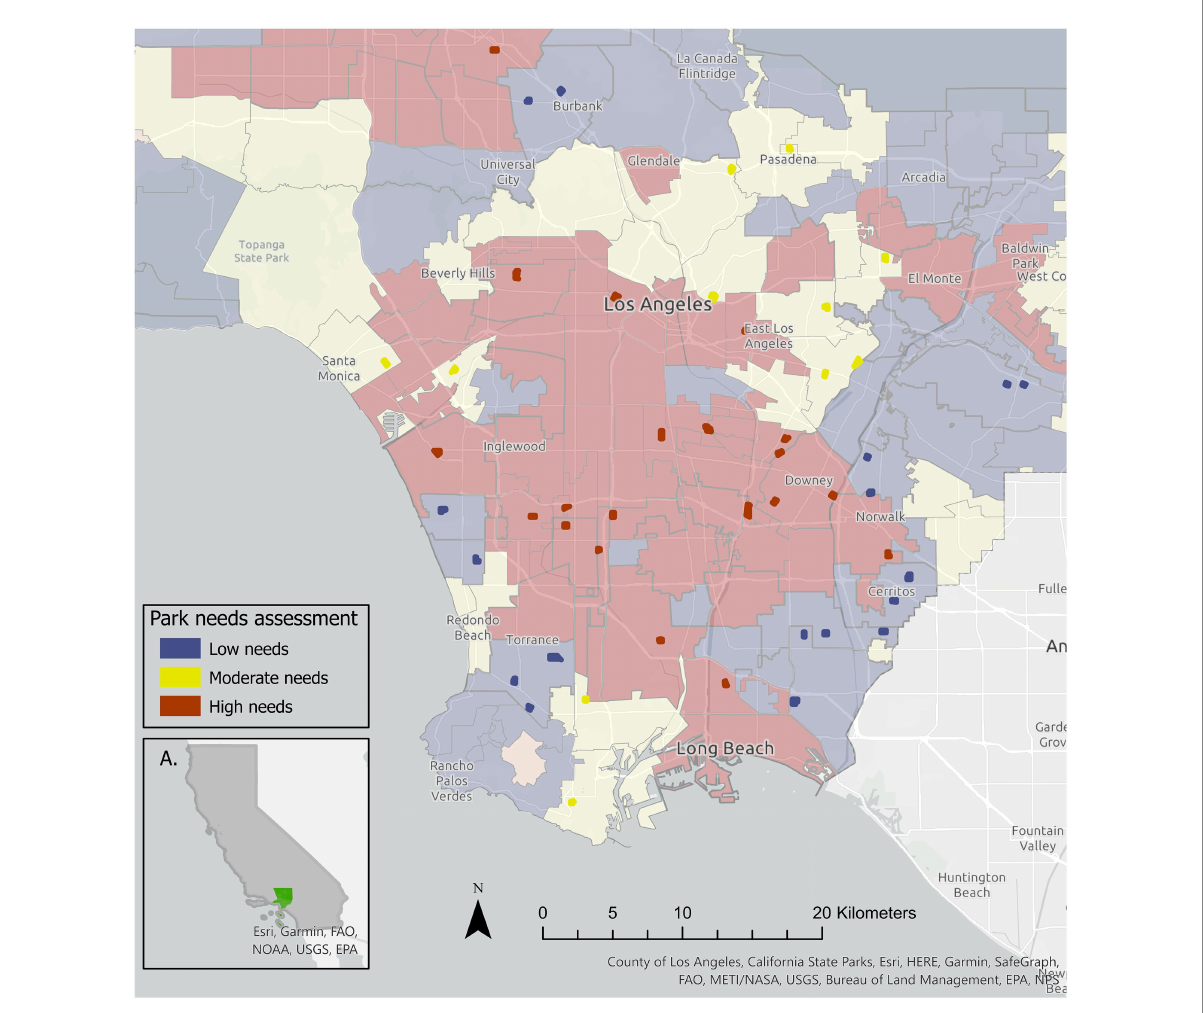
FIGURE 2 Locations of the 48 urban parks included in this study. The red, yellow, and blue color gradient indicates designations of Greater LA categorized by park need based on the Los Angeles Countywide Comprehensive Parks and Recreation Needs Assessment report (LA County, Department of Los Angeles County, 2016b). We grouped very high, and high needs parks into a ‘high needs’ group (red, n = 20), parks in We then included parks categorized within sections of the city as ‘moderate’ (yellow, n = 11) and ‘low’ (blue, n = 17)